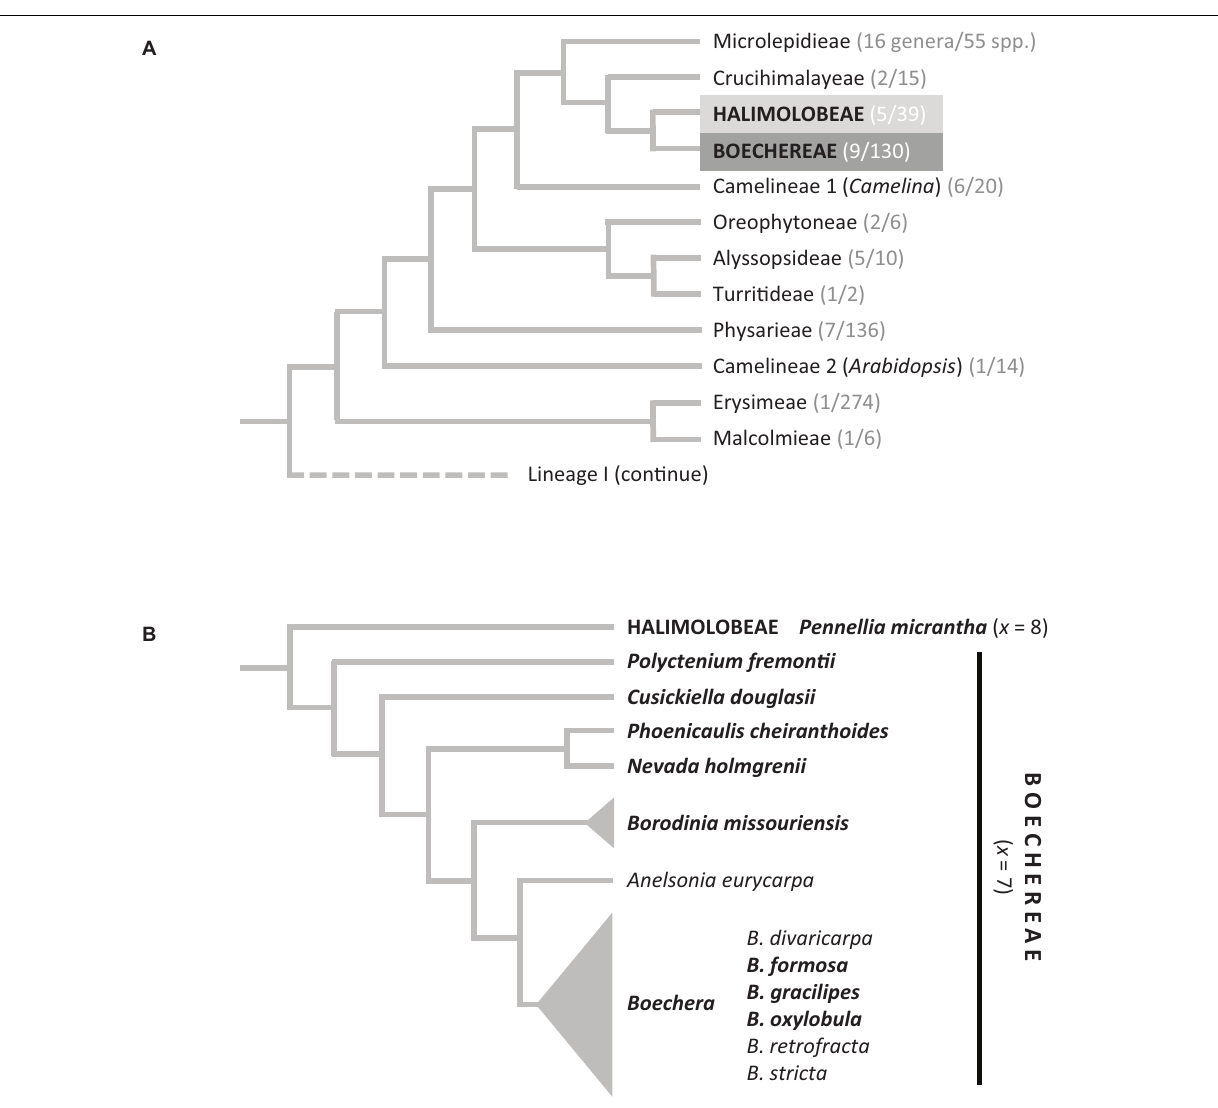
FIGURE 1 | (A) Phylogenetic position of the Boechereae in the Brassicaceae based on Nikolov et al. (2019). In parentheses, the number of genera and species is given based on data from BrassiBase (https://brassibase.cos.uni-heidelberg.de/). (B) Generic relationships within the Boechereae based on Beilstein et al. (2010) ( Sandbergia and Yosemitea not